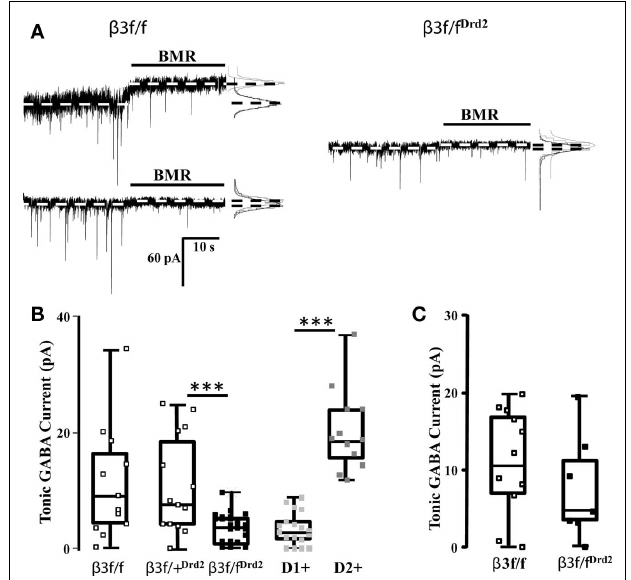
FIGURE 2 | Conditional β 3 subunit KO mice show reduced GABA-mediated tonic current in MSNs. (A) Individual representative current traces displaying MSN BMR-sensitive (25 μ M) tonic current in control β 3f/f mice (left) and β 3f/f Drd2 mice (right).The dichotomous pattern of tonic current was not present in β 3f/f Drd2 mice. (B) Summary box and whisker plots displaying the tonic current patterns in β 3f/f (open square, left; n = 13), β 3f/ + Drd2 (open square, middle; n = 14), β 3f/f Drd2 (black square, middle; n = 29), and wild-type BAC-D2-EGFP;Drd1a-tdTomato D1 + (light gray, right n = 15) and D2 + (dark gray, right n = 10) MSNs from at least three mice in each group. (C) Summary box and whisker plots